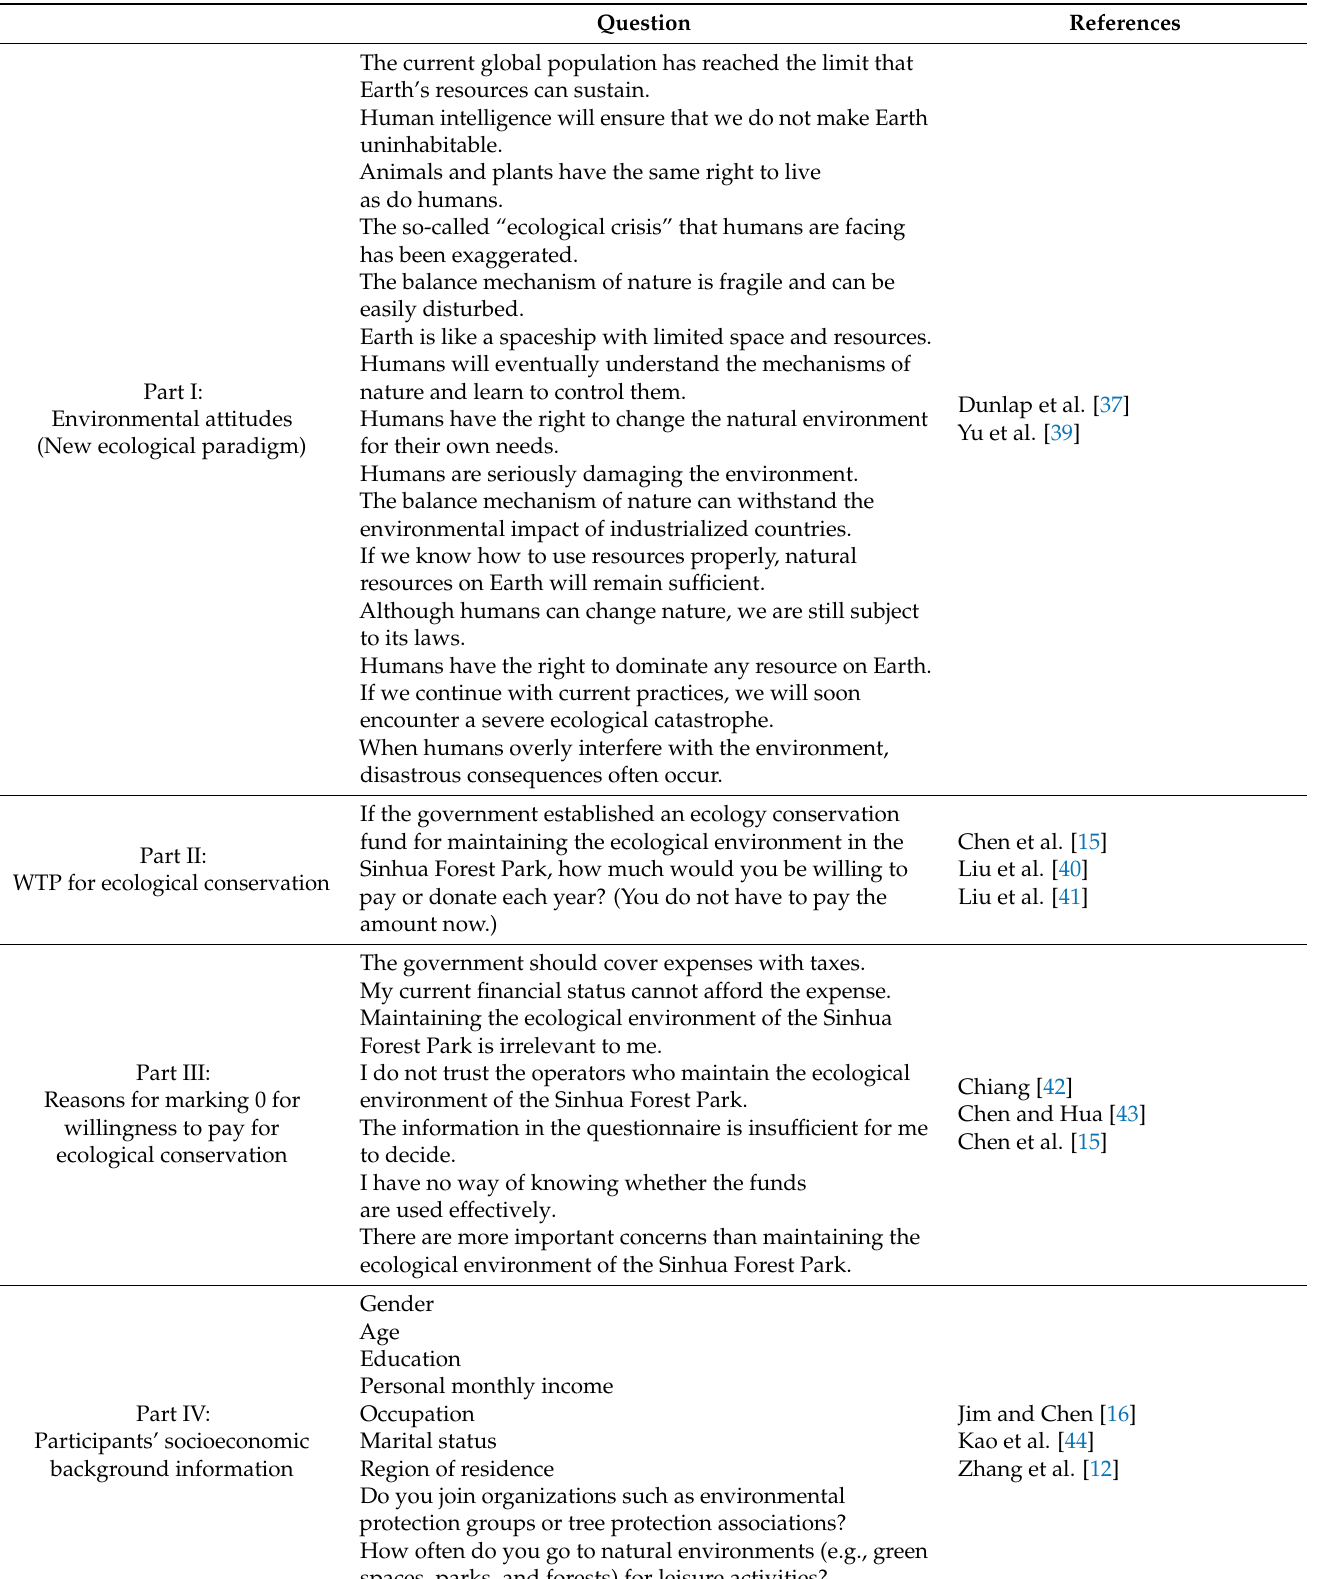
Table 1. Questionnaire